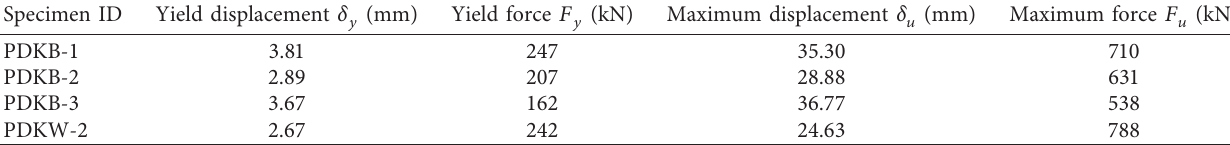
Table 9: Results of test displacement and actuator load.